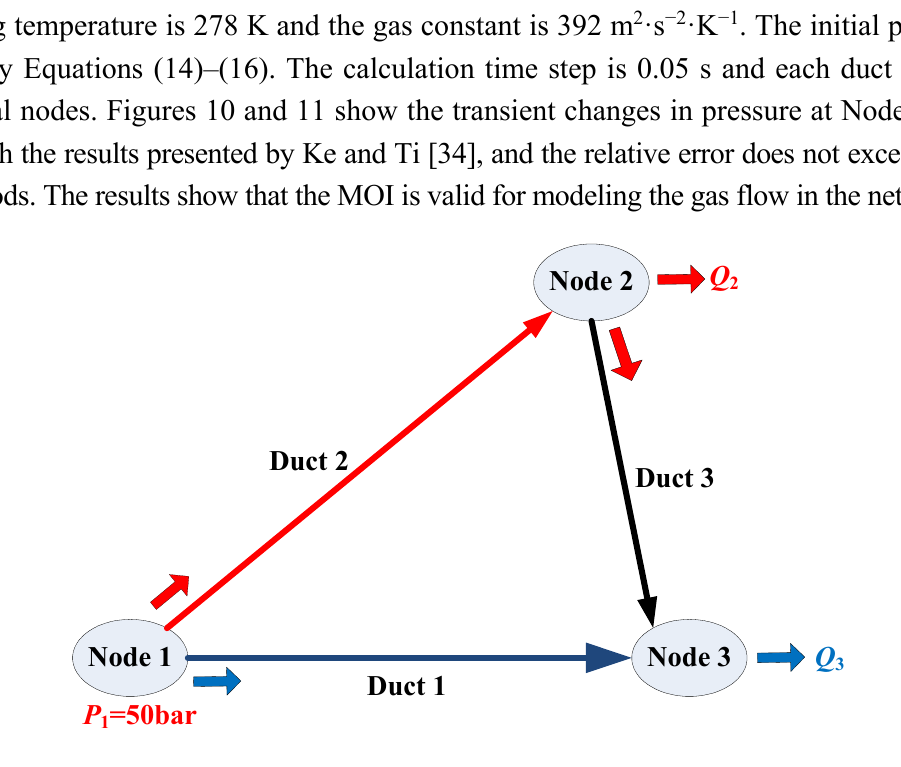
Figure 8. Schematic diagram of gas networks.